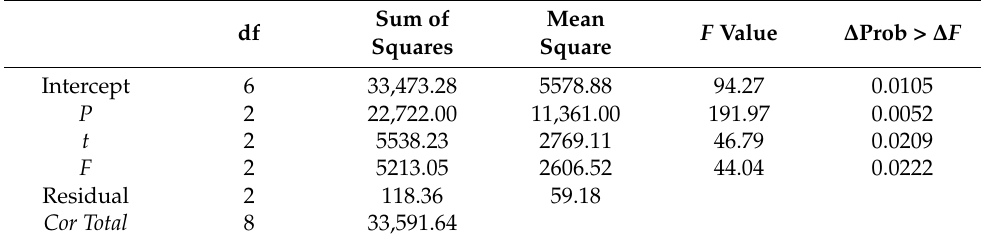
Table 5. Analysis of the variance results.